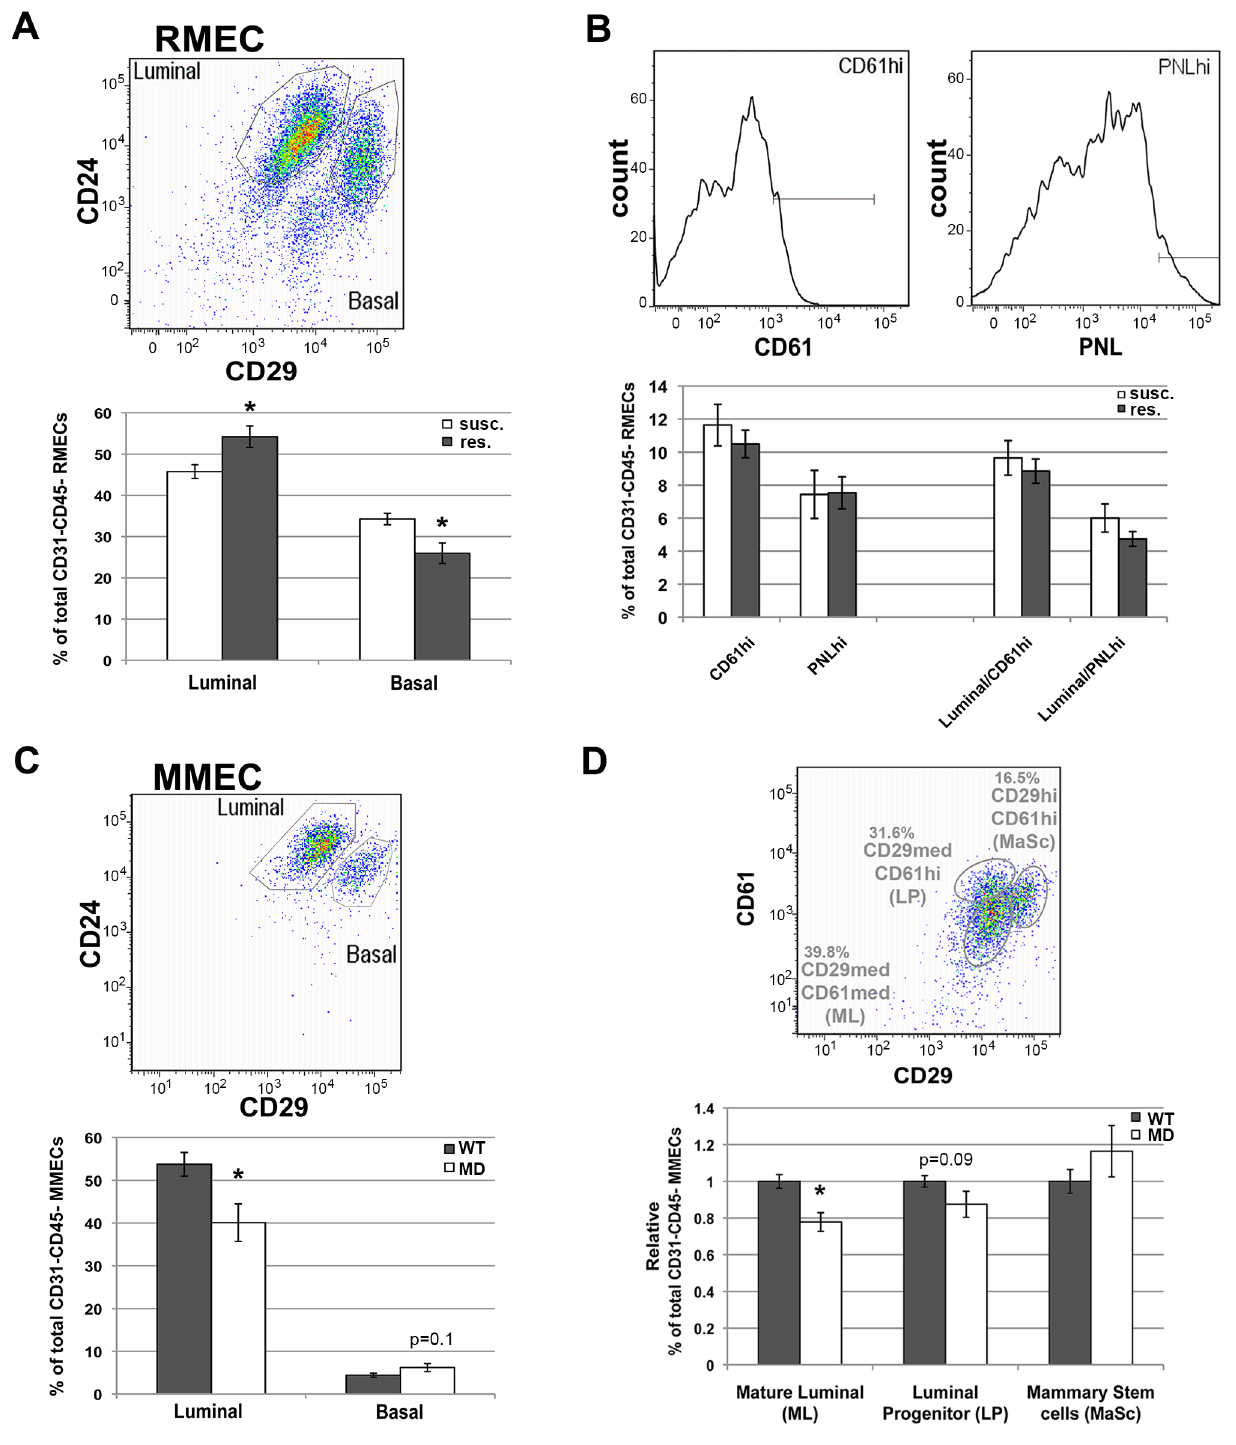
Figure 5. FACS analysis of rat and mouse MEC populations. A) Quantification of luminal and basal RMEC populations derived from susceptible congenic control (susc.; open bars; n=6; WF.Cop) and Mcs1a resistant congenic (res.; filled bars; n=7; Line W4) rats. B) Quantification of the CD61hi and PNLhi gates in RMEC populations derived from susc. (open bars; n=11; WF.Cop) and res. (filled bars; n=24; Lines W4 and W5). These gates were quantified in all CD31–CD45 2 RMECs as well as in the luminal RMECs. PNL=peanut lectin. C) Quantification of luminal and basal MMEC populations derived from wild type (WT; filled bars; n=30) and megadeletion (MD; open bars; n=27) mice (FVB and B6 pooled). D) Quantification of mature luminal (ML), luminal progenitor (LP) and mammary stem cell (MaSc) populations derived from WT (filled bars; n=30) and MD (open bars; n=27) mice (FVB and B6 pooled). FACS pseudocolor dot plot or histograms in each panel’s upper figure illustrate the gating strategies used to quantify specific MEC populations. These dot plots were taken from a susc. sample (RMEC), or from a WT (FVB) sample (MMEC). Graphed in panels A– C are the average ( + / 2 sem) percentages of populations among CD45–CD31 2 MECs. Graphed in panel D is the average ( + / 2 sem) percentage of population among CD45–CD31 2 MECs, expressed relative to the WT run on the same day. In all graphs, significantly different (P , 0.05) percentages of cells between susc. and Mcs1a or between WT and MD are indicated with an asterisk. doi:10.1371/journal.pgen.1003549.g005 PLOS Genetics |